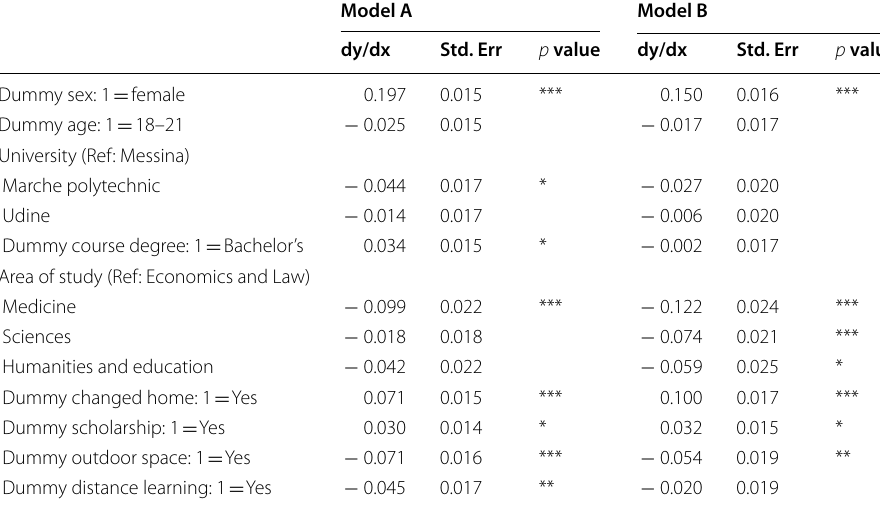
Table 8 Marginal effects of the Probit